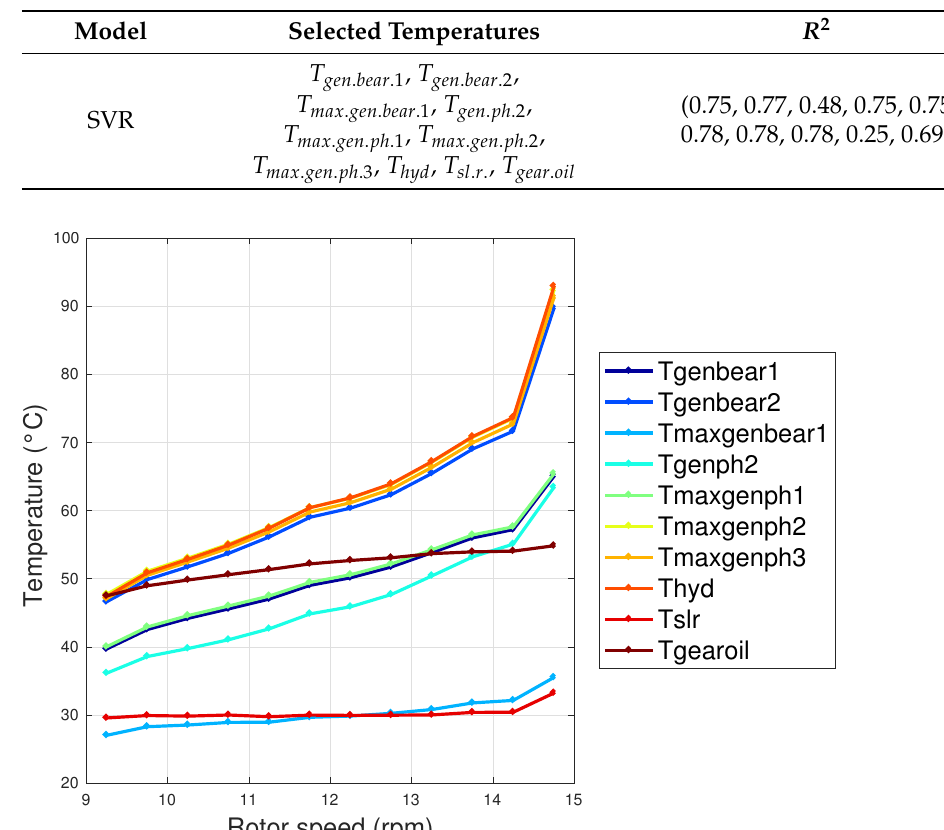
Table 2. Coefficient of determination between the internal temperatures selected for the SVR regres- sion and the rotor speed ω .